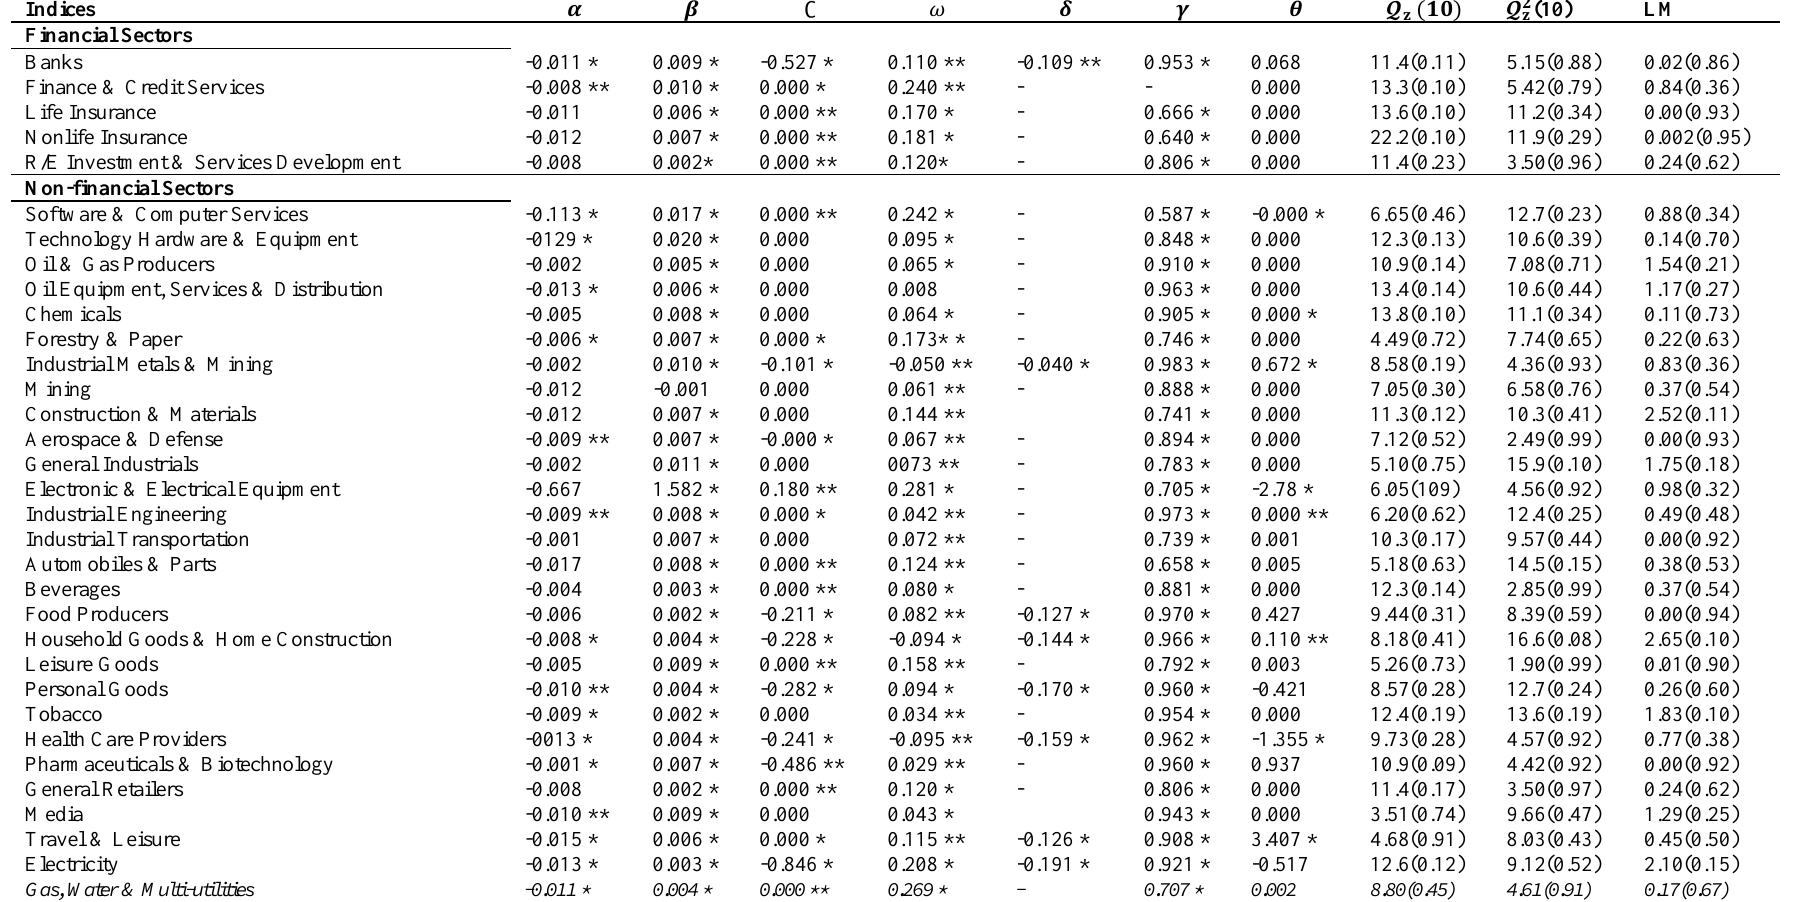
Table 3: the impact of the September 11 th attack on the volatility of financial and non-financial sector